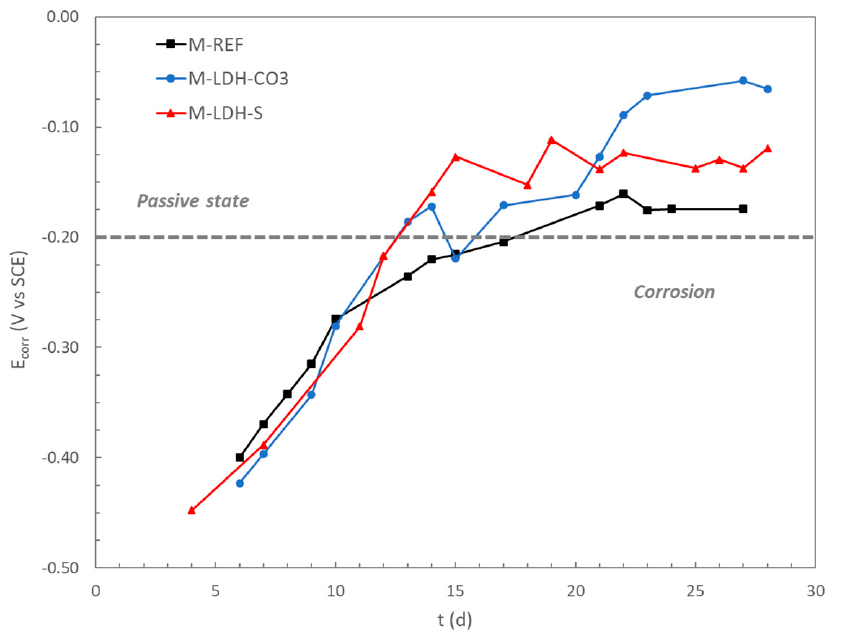
Figure 5. Evolution of the corrosion potential for the three studied reinforced mortars during the passivation stage.